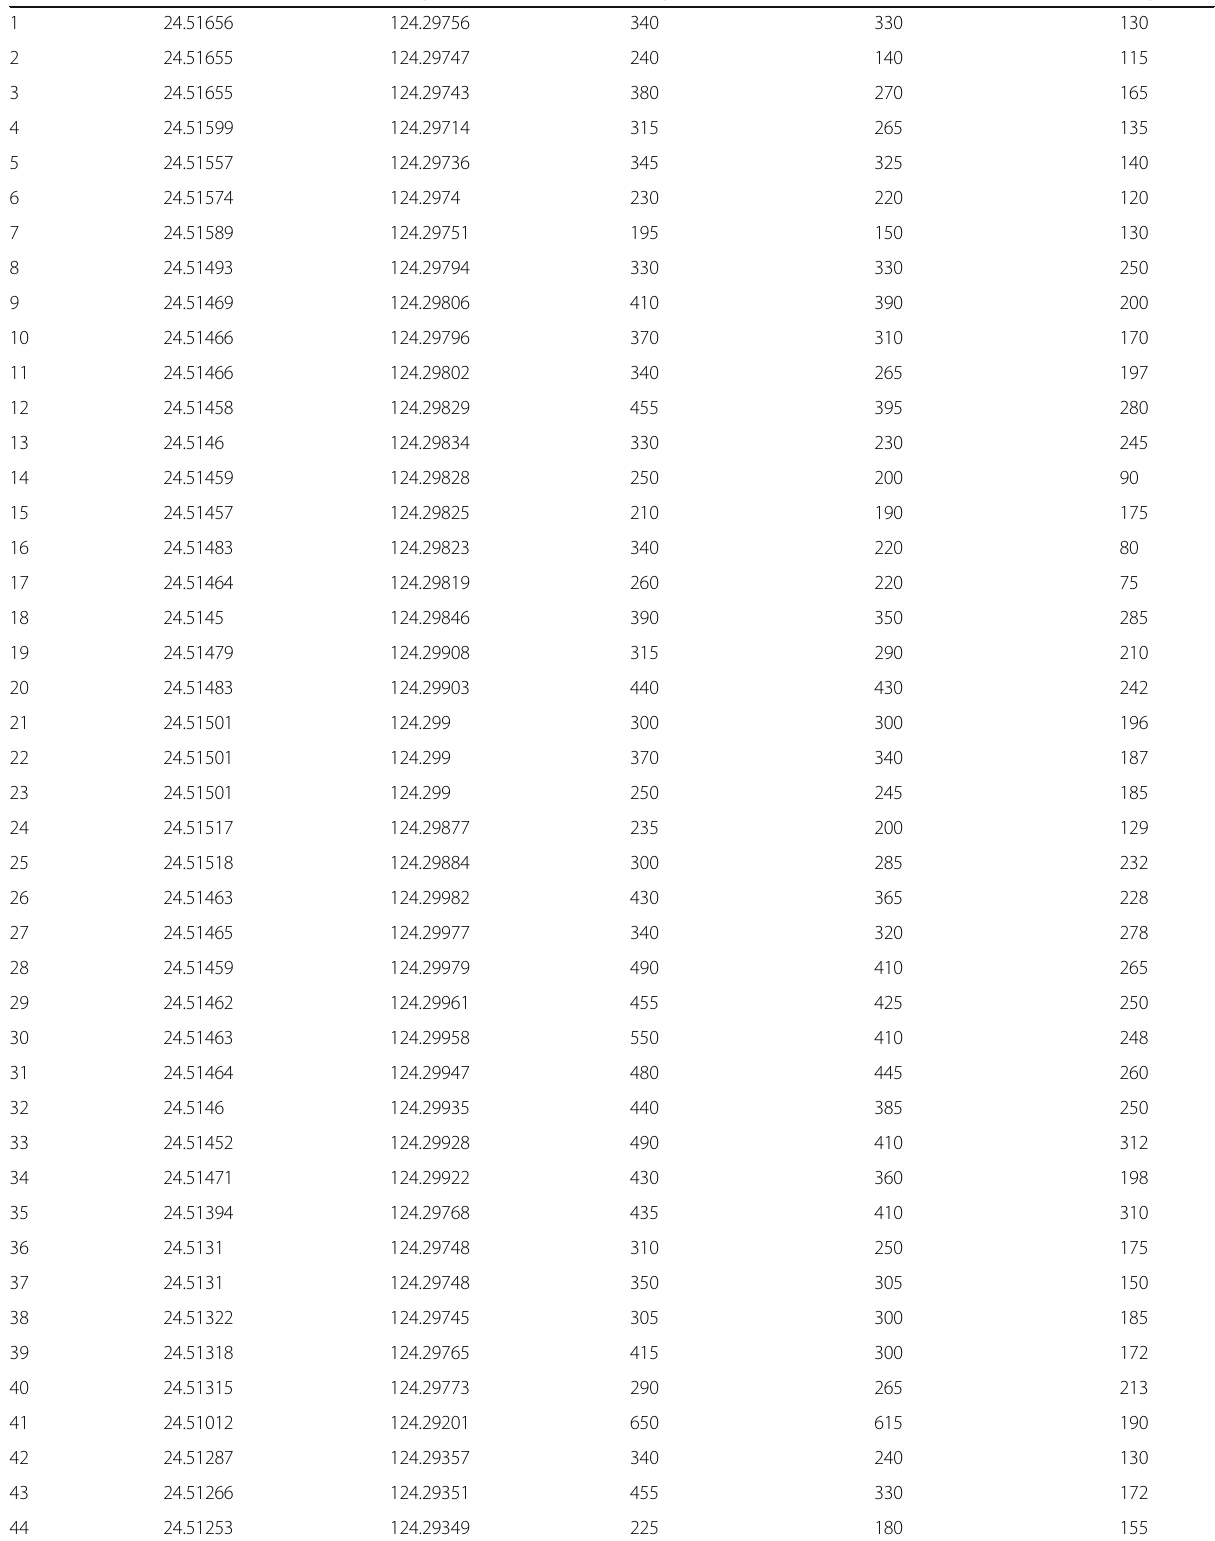
Table 1 Locations and three dimensions of measured living massive